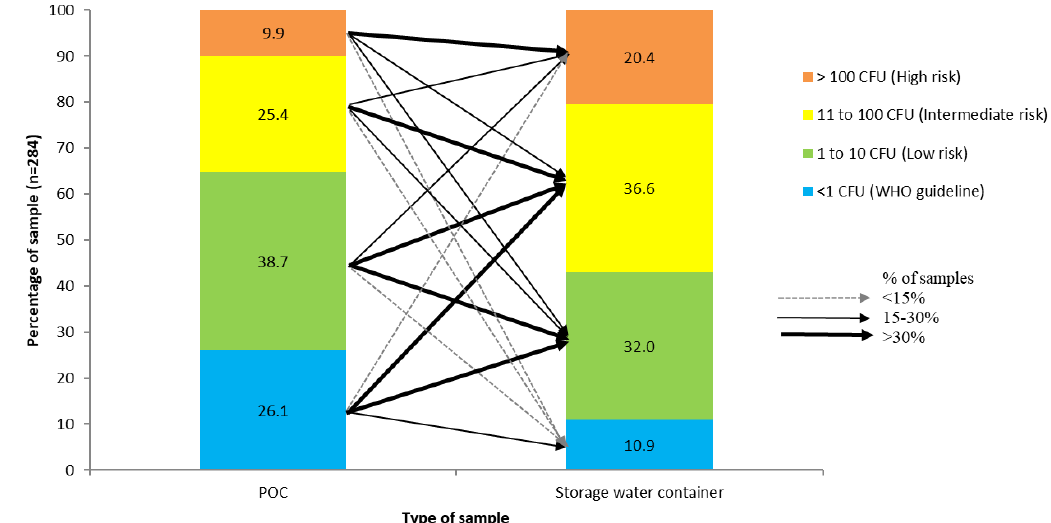
Figure 6. A graph of how water quality changed from POC to storage container. The values in the bar show the percentage of samples in each color category. The thickness of the arrow pointing to the second bar indicates the proportion of the samples that moved to that category.